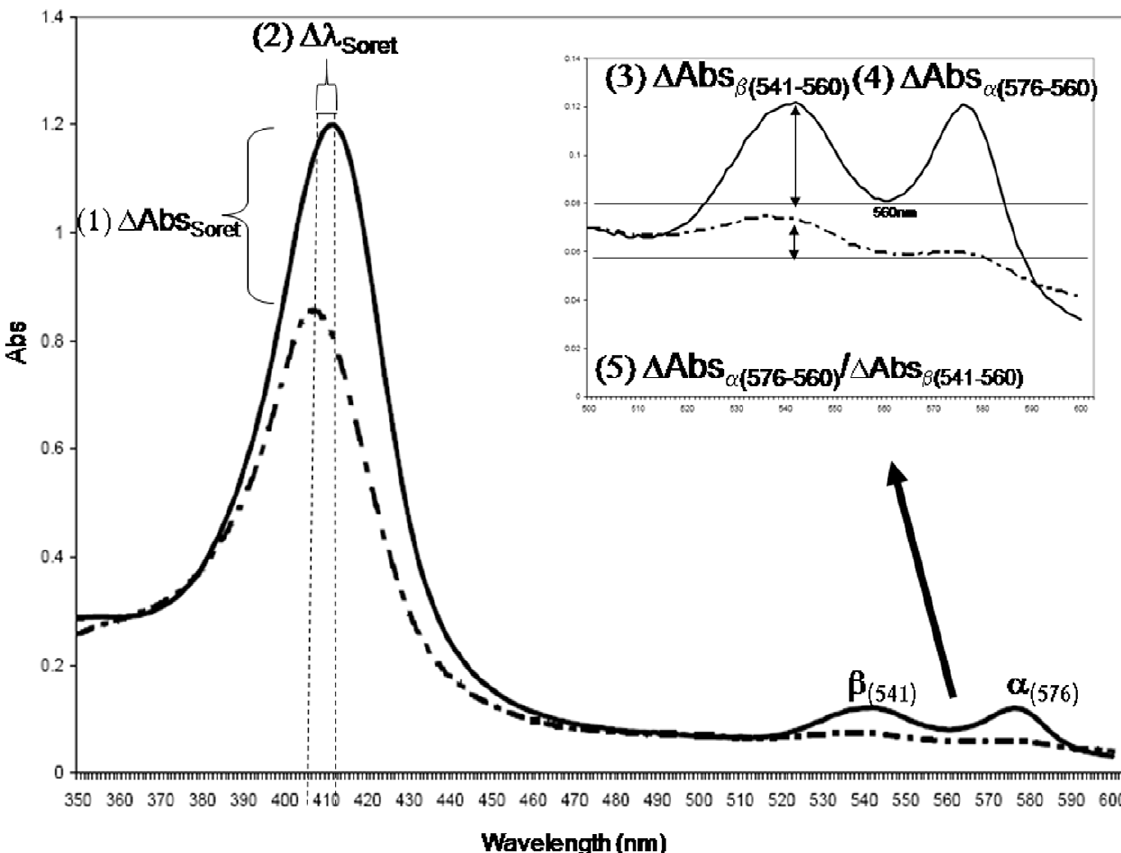
Figure 1. Hemoglobin UV-VIS spectral shift parameters. UV-VIS spectral profiles from bloodstains stored at room temperature for 15 minutes (solid line) and 1 year (dashed line) were compared in order to identify potential differences between ‘‘fresh’’ and ‘‘old’’ stains. The putative time- dependent parameters (1–5) involving changes in the Soret band and a and b peaks are indicated (1–5).